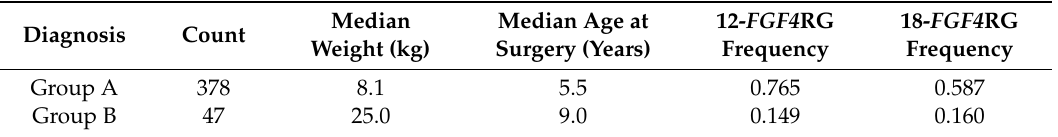
Table 3. IVDD phenotypes among surgical cases. Dogs included in Group A had evidence of calcified intervertebral discs either radiographically or at the time of surgery, while dogs categorized as Group B had no evidence of disc calcification on radiograph or at time of surgery.